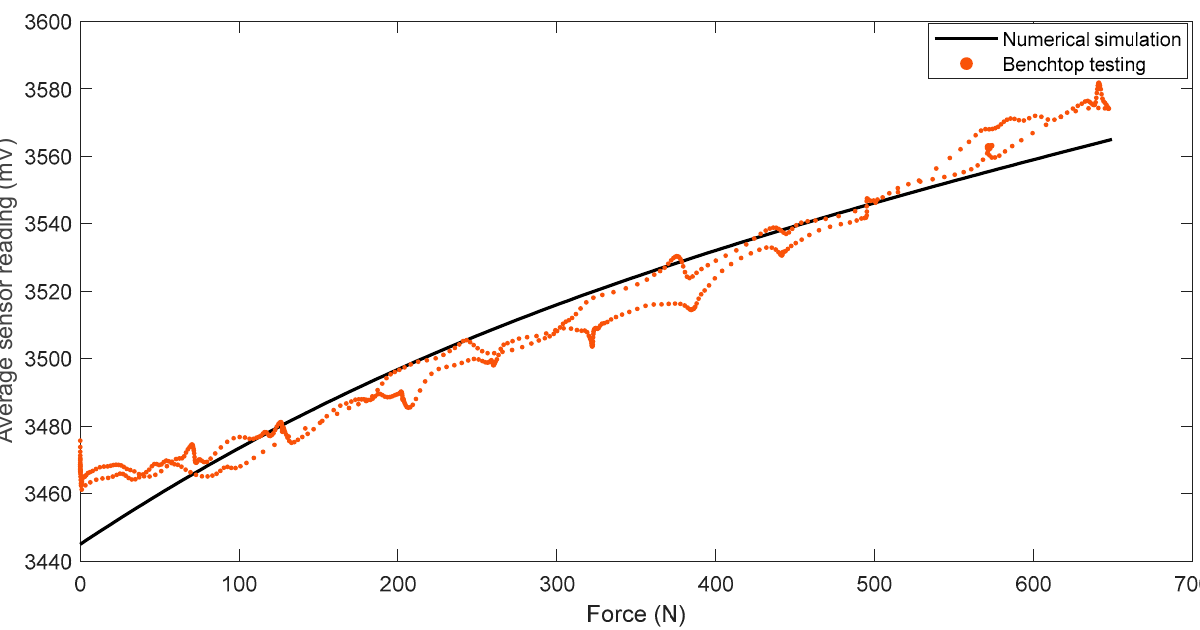
FM-PLS during the axial force change.